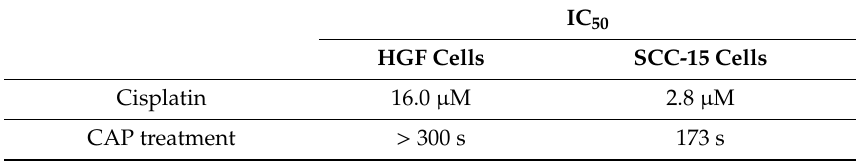
Table 1. IC 50 of cisplatin and CAP treatment against SCC-15 cells.